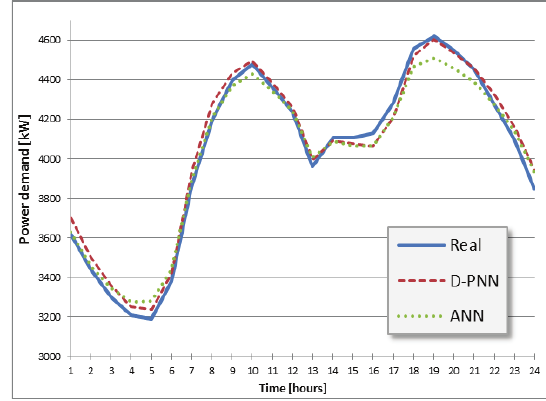
Fig. 4. TEPCO : 1.2.2012 (Wednesday). D-PNN RMSE = 51.5 , ANN RMSE = 56.8